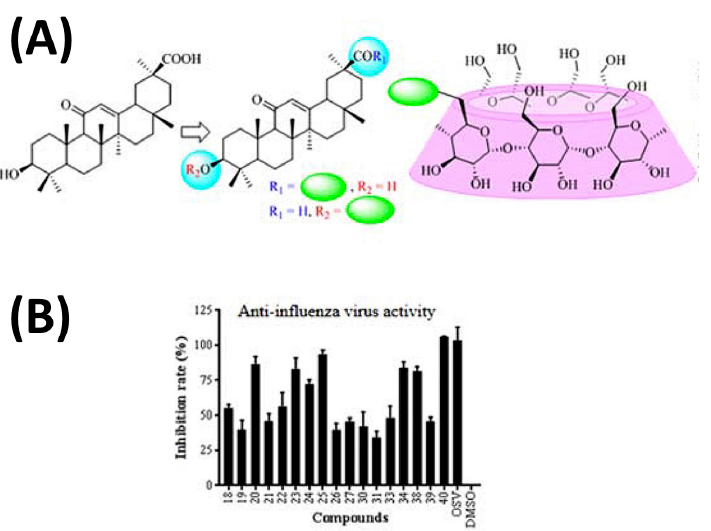
Figure 10. Schematic representation of the synthesis approach to conjugate glycyrrhetinic (GlyA) acid ( A ) to β -cyclodextrin and ( B ) their efficacy in inhibiting influenza virus infection. Accordingly, the conjugation of GlyA complexed to β -CD has demonstrated beneficial results for treating influenza virus agents. Adapted from [82], Copyright (2021), with permission from